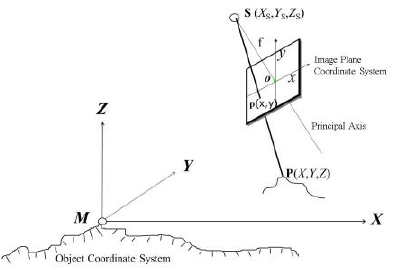
Figure 1. Geometric structure of perspective projection defined by the collinearity